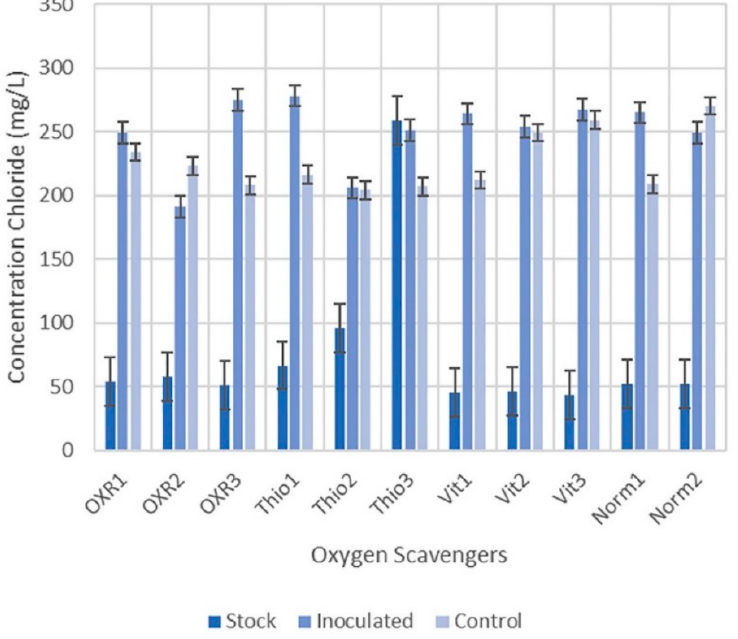
Figure 6. Illustration of chloride content with standard error bars for oxygen scavenger initial (Stock) solutions, and after treatment for inoculated and control samples of Oxyrase ® (OXR), Sodium Thioglycolate (THIO), Vitamin C (VIT), and no scavenger added (NORM) at their respective concentrations outlined in Table 2.